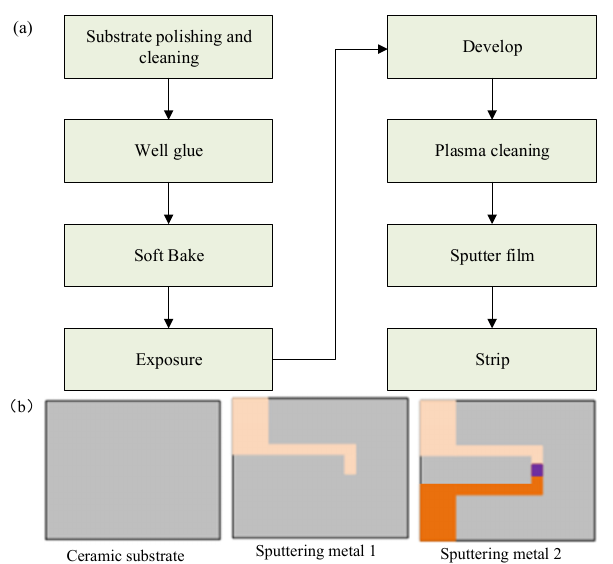
Figure 3. The detailed process and effect drawing of thin-film thermocouple prepared by magnetron sputtering method: ( a ) Diagram of sputtering process; ( b ) Ceramic base and two different sputtered metals.